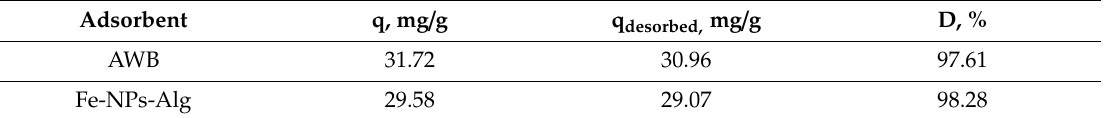
Table 4. Desorption e ffi ciency of Cu(II) ions on exhausted AWB and Fe-NPs-Alg